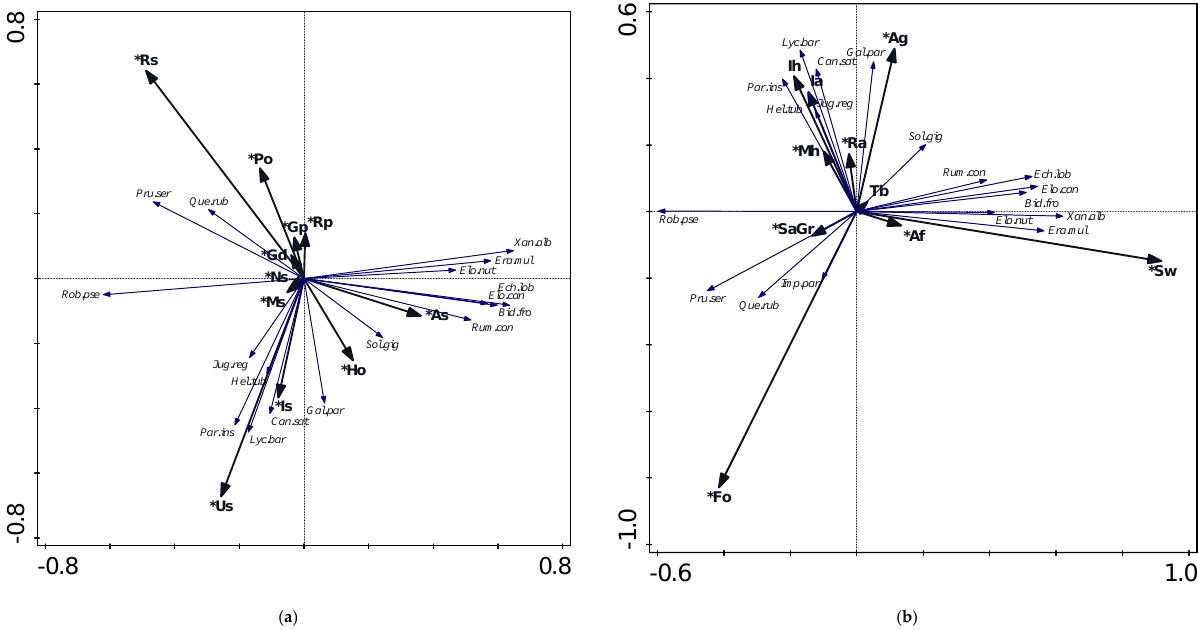
Figure 1. Results of redundancy analysis (RDA) with forward selection and Monte Carlo permutation test: ( a ) relation between invasive plant species distribution and urban soil types, species over 3% fit are presented in ordination space of axis I and II; ( b ) relation between invasive plant species distribution and habitat types, species over 3% fit are presented in ordination space of axis I and II. * significant variables ( p < 0.05). Abbreviations of urban soil types and habitat types as in Table 1. Abbreviations of plant names consist of the first three letters of the genus name and the first three letters of the species name, e.g., Que.rub— Quercus rubra L., Pru.ser— Prunus serotina Ehrh., full list in Table S1.